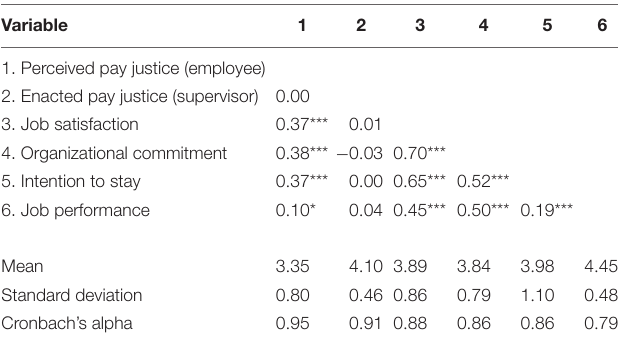
TABLE 1 | Descriptive statistics, reliability estimates, and correlations for the study variables.